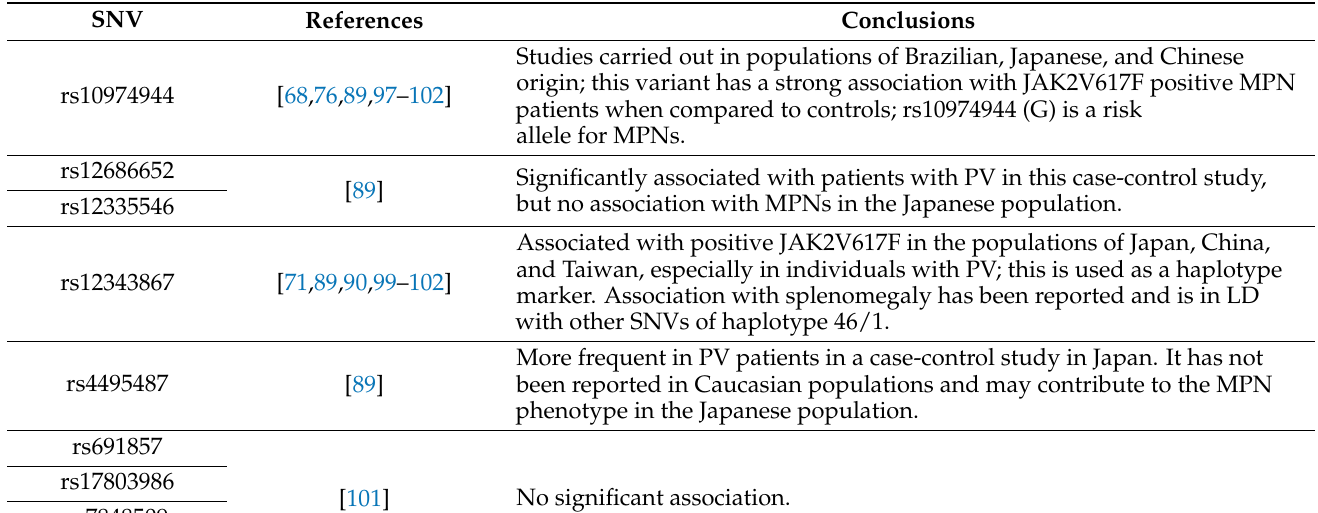
Table 2. Single nucleotide variants (SNVs) identified in studies on the 46/1 haplotype and their respective information described in the